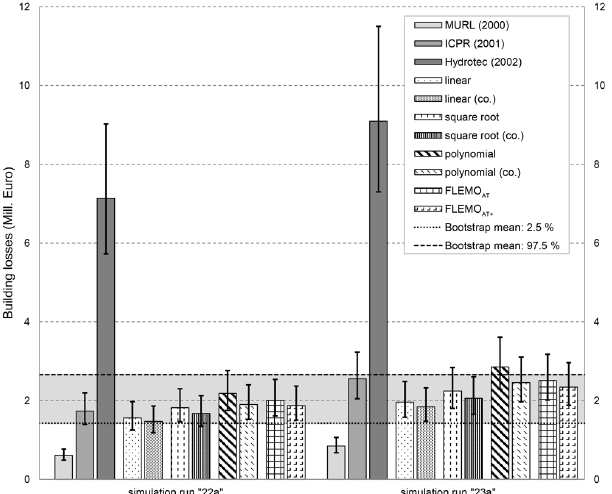
Fig. 6. Current risk curve for residential areas with associated un- certainty bounds based on the range of 29 plausible model combi- nations (i.e., successfully validated models), and based on the range of 28 additional, non-plausible loss model combinations. The most accurate functions (i.e., the smallest deviation to the observed loss) in case of the hydraulic-simulation runs “22a” and “23a” for 2005 are shown in dotted